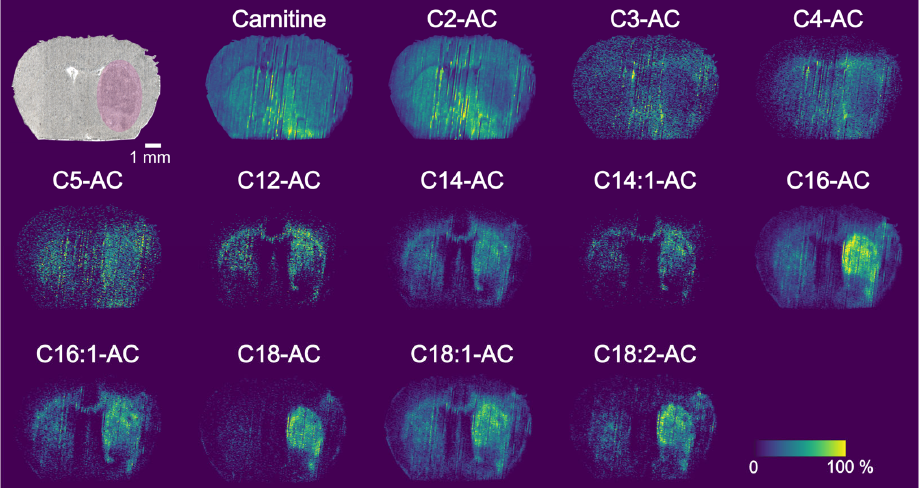
Figure 3. Ion images of various carnitines obtained through PA nano ‐ DESI MSI. The optical image of MCAO mouse brain tissue section shows the pink area as the ischemic region. The ion images of carnitine and various acylcarnitines are depicted as normalized intensities to carnitine ‐ d3 (C to C5) or C18 ‐ carnitine ‐ d3 (C12 to C18). Color map scale shows relative